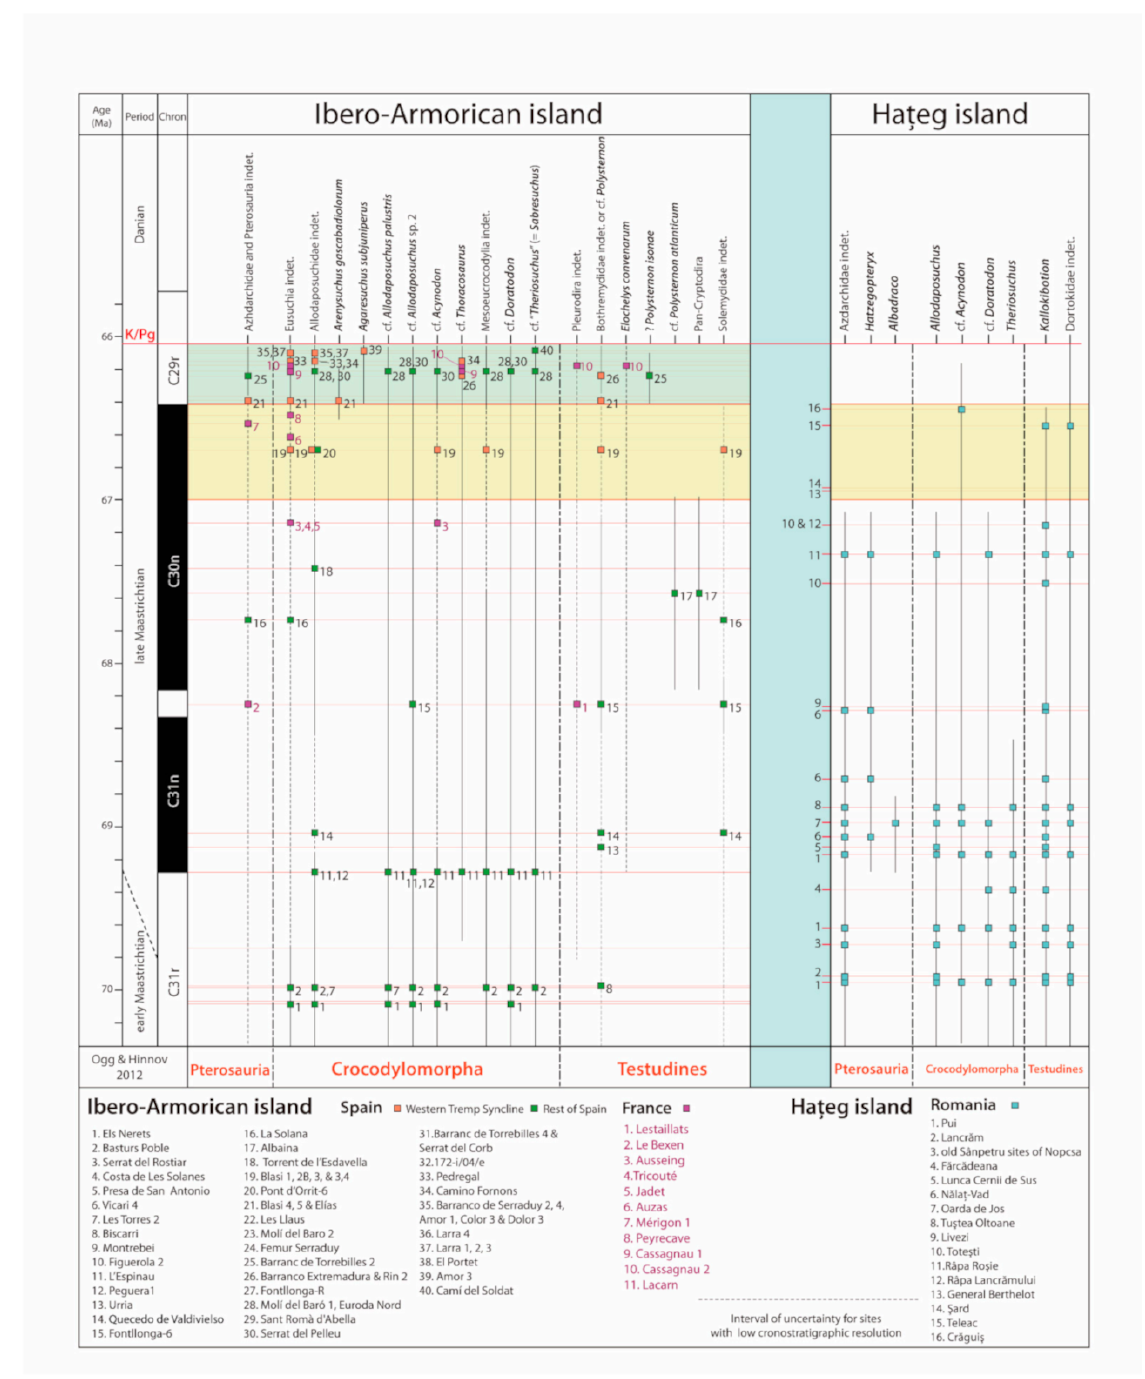
Figure 9. Pterosaur, crocodylomorph, and testudines groups and species occurrences in the Ibero-Armorican island and Ha¸teg island during the late Maastrichtian. Ha¸teg island data based on [32] with updated information. The yellow band marks the temporal interval used for comparison, whereas the green band marks the last ≈ 350 ka of the Maastrichtian, with a record only in the Ibero-Armorican island. Magnetochronostratigraphic scale based on [153] and calibration for the K-Pg boundary based on